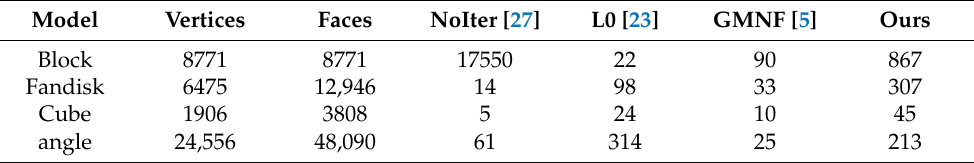
Table 5. Running time